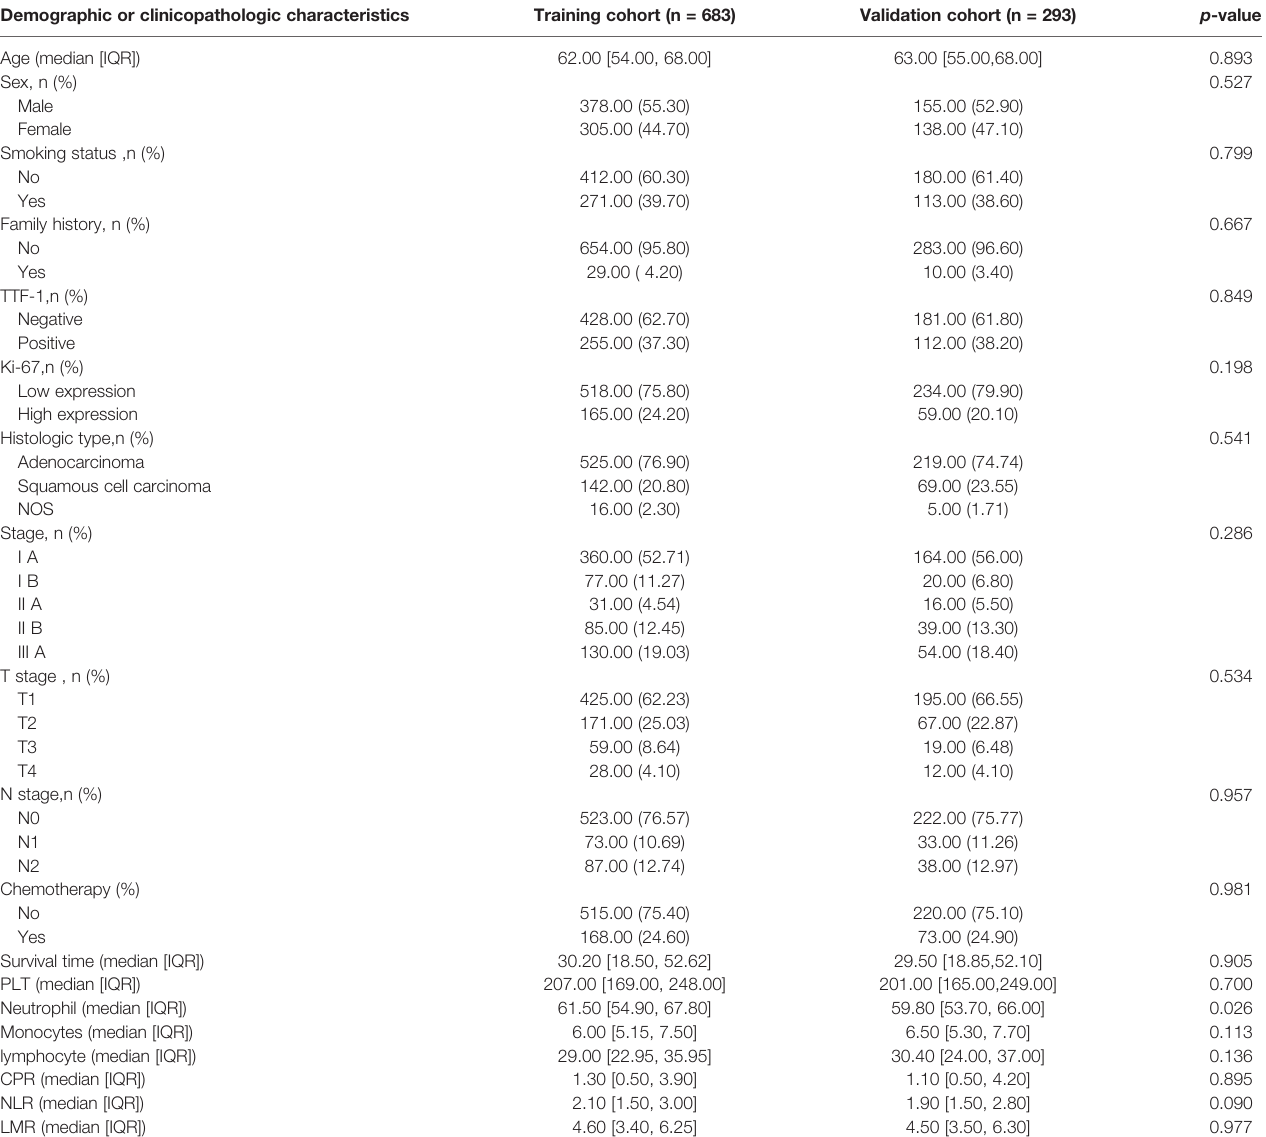
TABLE 1 | Demographic and clinicopathologic characteristics of patients in the training and validation cohorts. Demographic or clinicopathologic